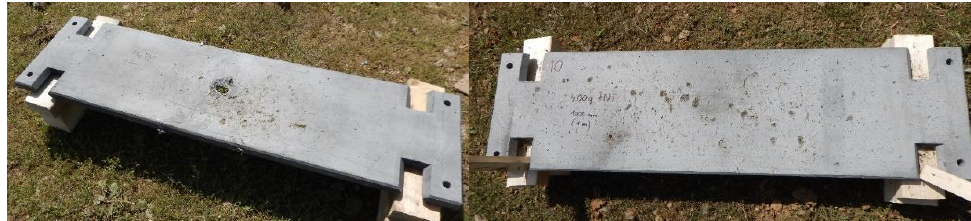
Figure 17. Local damage (LD) of the UHPFRCC slab due to the contact explosion from 75 g of TNT (on the left) and frontal erosion (FE) of the UHPFRCC slab from the blast experiment of 400 g of TNT from 1 m (on the right).